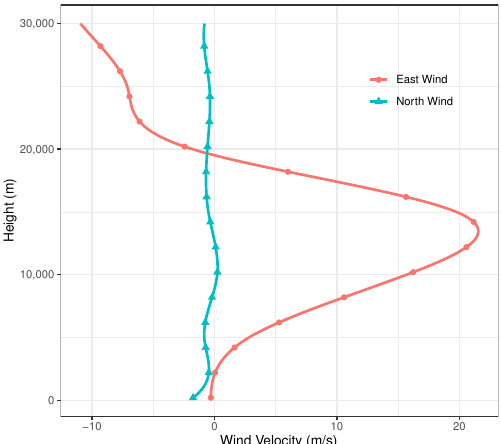
Figure 4. North and east component of the wind velocity in summer.